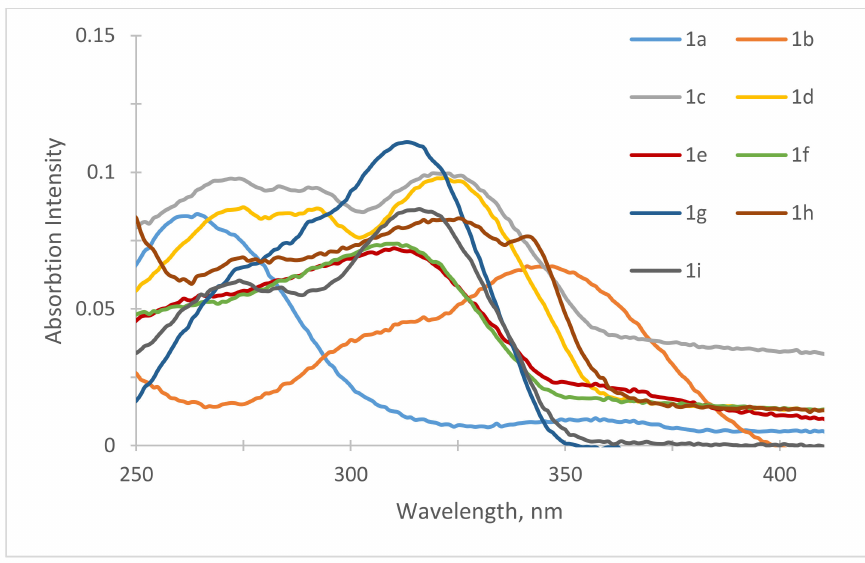
Figure 4. Absorption spectra of 1a–1i in dichloromethane at room temperature.